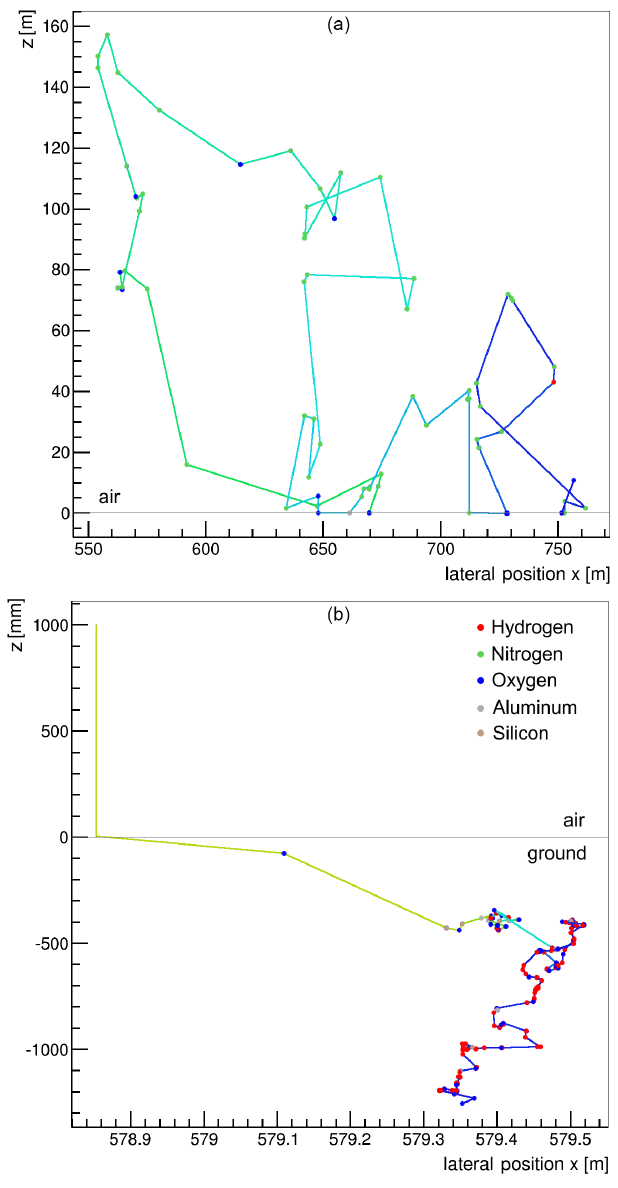
Figure 10. Projection of track calculations in an air–ground inter- face. The simulated neutrons, which are artificially released from 1m above the soil, are rainbow-colored according to the logarithm of the corresponding energy scaling from 10MeV (red) to thermal (blue). (a) A neutron which mainly scatters in the air. (b) A neutron thermalizing inside the soil. To be noted: both x and y axes are not scaled